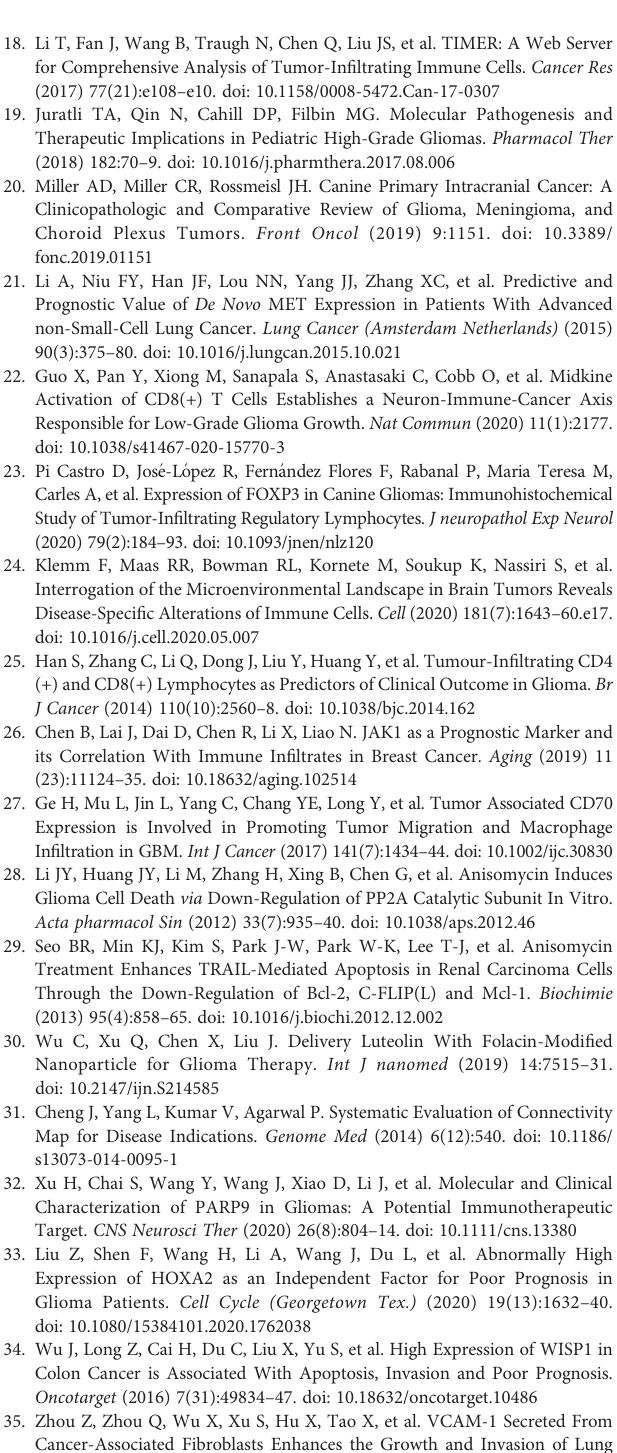
Supplementary Table 1 | Characteristics of patients with glioma based on CGGA. CGGA, Chinese Glioma Genome Atlas; WHO, World Health Organization; IDH, Isocitrate